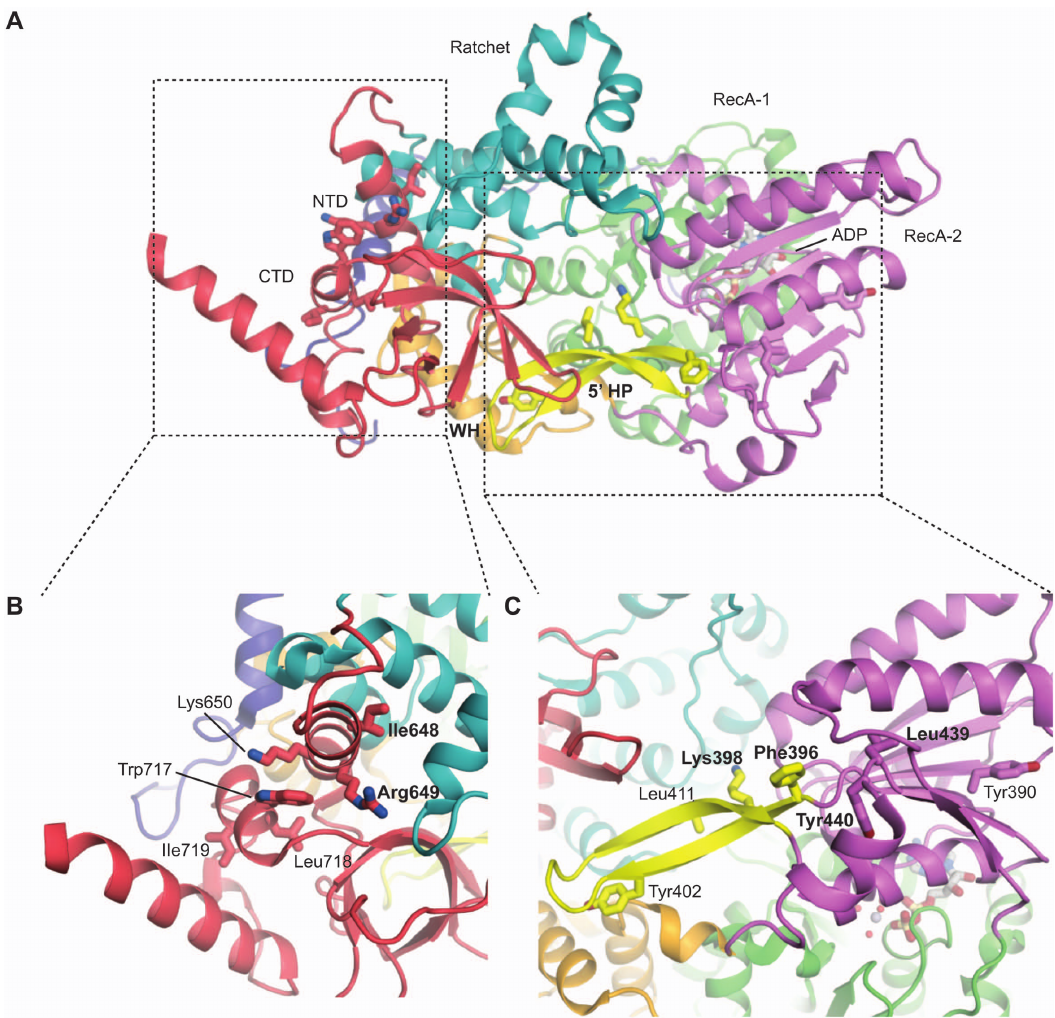
Figure 7 The putative interaction surface of Prp43p with G-patch proteins. (A) The RecA-2-5 9 HP–CTD side of Prp43p might be the primary interaction surface. Mutations of several residues within these domains likely disrupt binding to G-patch proteins. These residues are shown as sticks and highlighted in close-up in (B) and